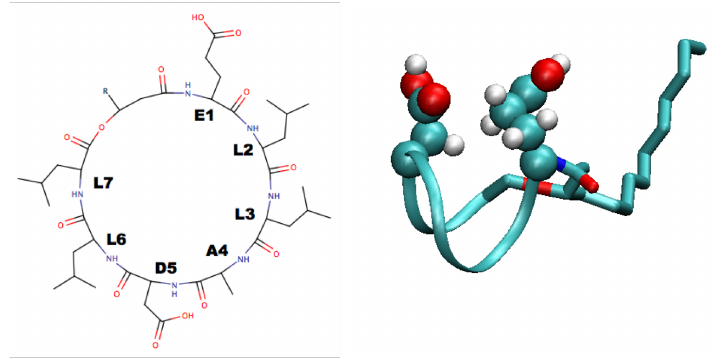
Figure 3. Surfactin structure. The left hand panel shows chemical structure. The R group is a 12 to 17 carbon atom alkyl chain. The right hand panel shows 3D structure, with Glu and Asp residues highlighted, generated using VMD [79] (from PDB structure